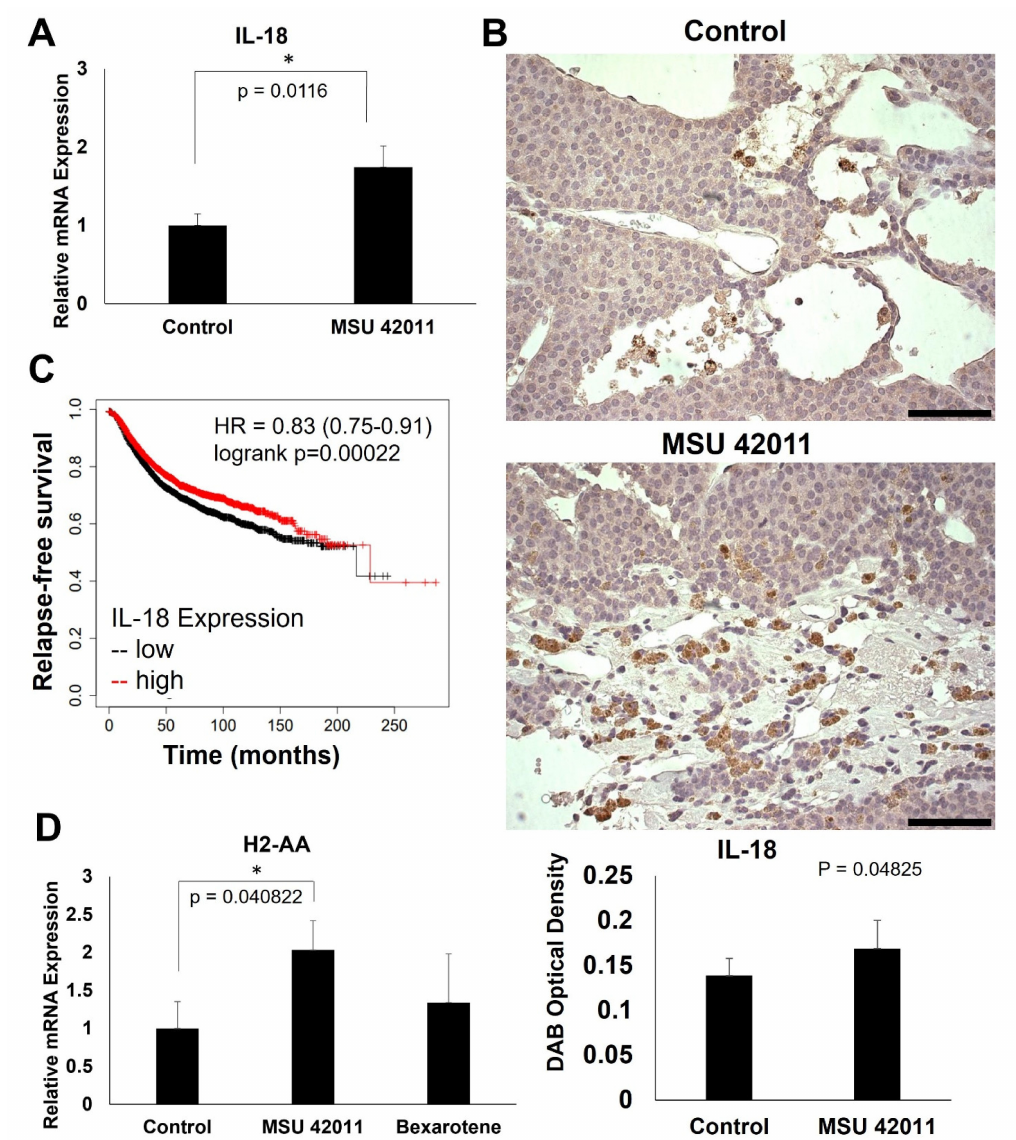
Figure 6. MSU-42011 increases IL-18 and H2-AA expression in mouse mammary tumors. Tumors treated with MSU-42011 (100 mg/kg diet) or control were harvested and flash-frozen. Tumors were homogenized and RNA extracted. ( A , D ) Gene expression was detected by qPCR. N = 5 mice/group. Error bars represent standard error. * p < 0.05 ( B ). Immunohistochemical staining for IL-18, rep- resentative of four mice per group and quantified using ImageJ. Scale bar represents 60 µ m, 40 × magnification ( C ) Kmplot survival curve correlates expression of Il-18 with survival in breast cancer patients (n = 4929; 2456 high, 2473